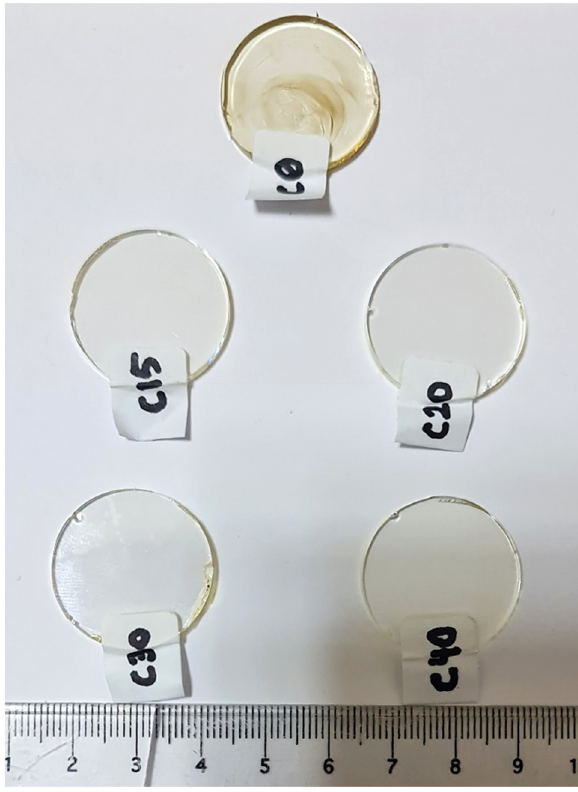
Figure 1: Synthesized glass series.